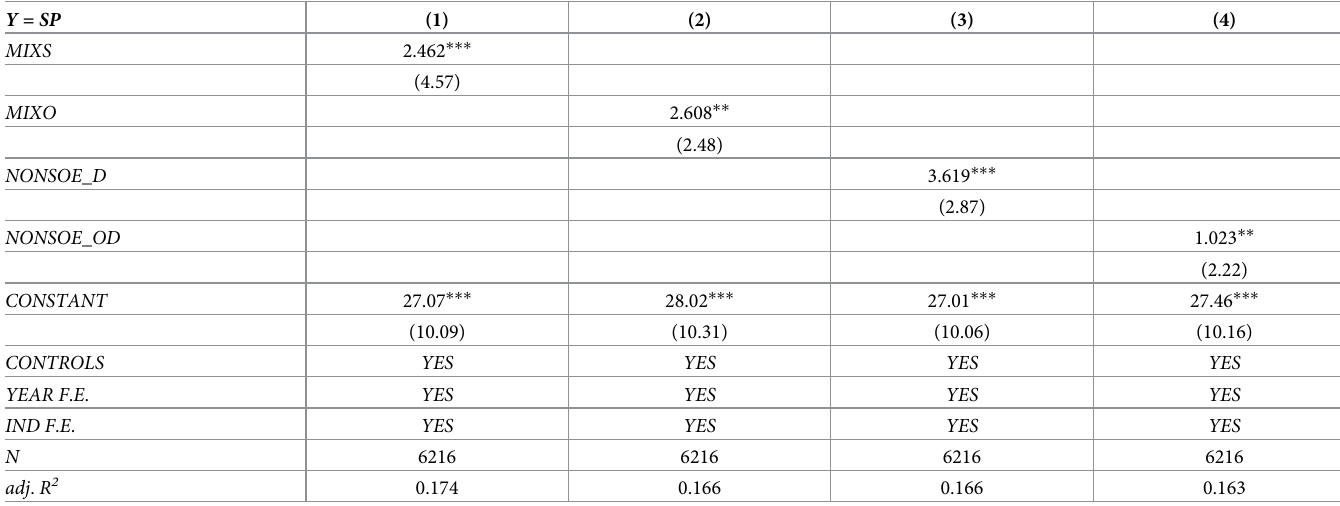
better. Table 5 shows the empirical results after pairing. The diversity of mixed shareholders, the depth of mixed equity, the control of mixed equity, and the excess control of mixed equity are significantly positively correlated with the enterprise strategy. The above results are consis- tent with the main regression results, which proves the robustness of the research conclusions of this paper. 3 . Multiple-period forwarded explained variable . Mixed-ownership reform exerts an impact on the SOEs’ strategic choices. Once the strategic positioning of SOEs is determined, non- Table 5. The regression results after PSM